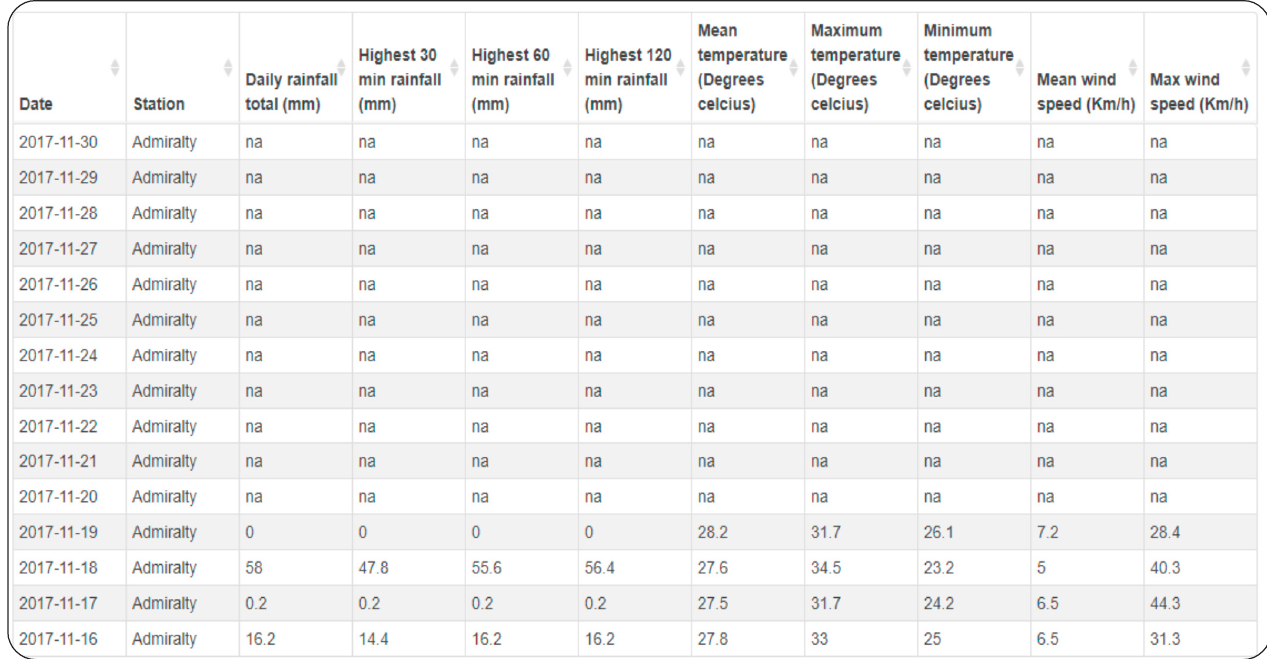
Figure 9. A sample of the used dataset.